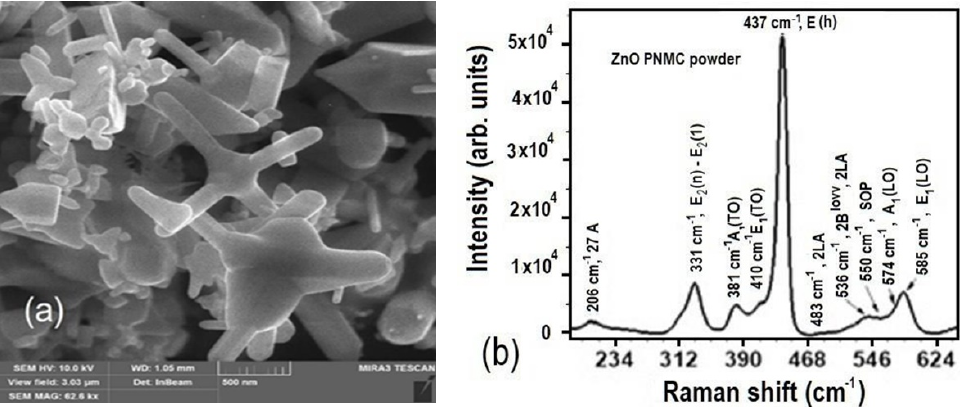
Figure 1. ( a ) SEM image of morphology of the PNMC ZnO powder after cold pressing; ( b ) Raman scattering spectrum of the PNMC ZnO powder at room temperature; vibration modes of the first order are marked in bold.